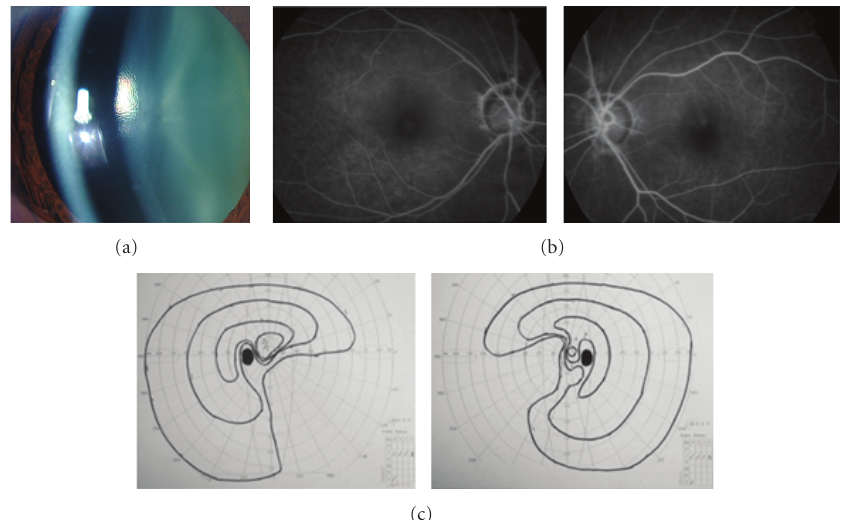
Figure 2: Clinical findings of a patient with Castleman disease after tocilizumab treatment. Panel (a) shows a slit-lamp photograph of the anterior chamber after tocilizumab treatment. Large cells disappeared three months after tocilizumab treatment. Panel (b) shows FA findings after tocilizumab treatment. The degree of leakage improved three months after the tocilizumab treatment. Panel (c) shows nasal visual filed defects observed in Goldmann perimetry in both eyes three months after treatment because of secondary glaucoma before the tocilizumab